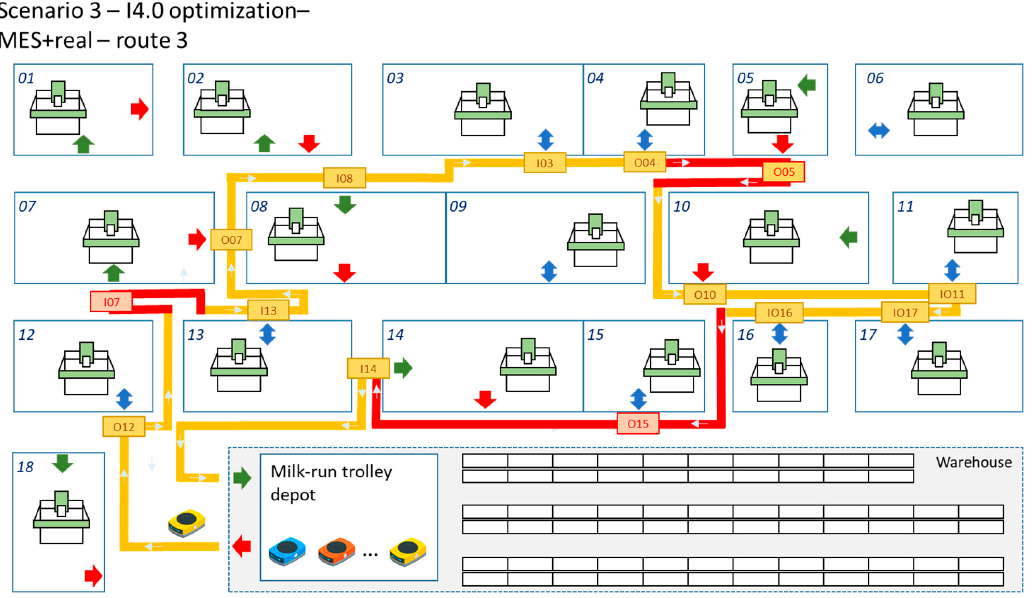
Figure 13. The modified third route of the I4.0 technologies supported real-time milk-run-based in-plant supply including MES data-based supply demands and digital-twin-generated real-time supply demands. Red lines of the route represent the real-time added route